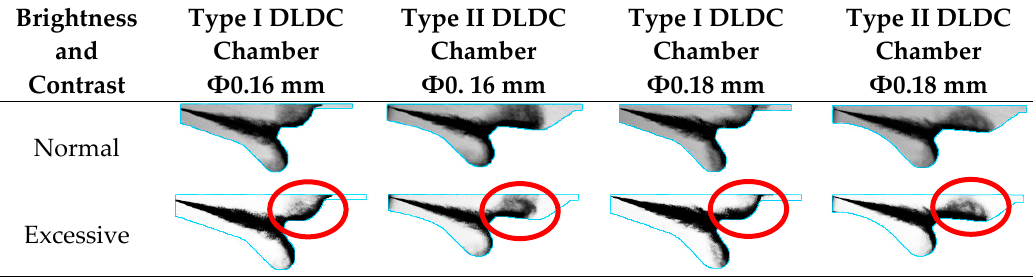
Figure 14. The comparison of fuel spray distributions at 1.4 ms ASOI under different brightness and contrast with medium load, different nozzles, 150 MPa injection pressure and 5 °CA BTDC injection timing of Mode B.